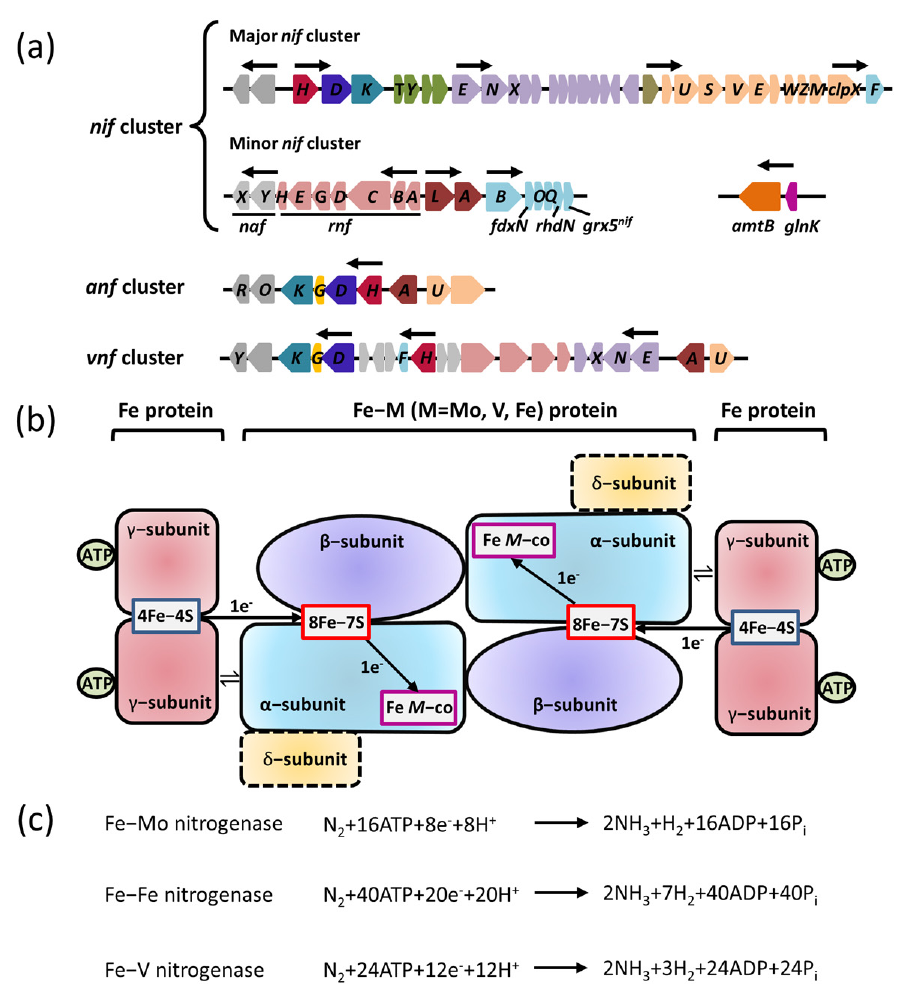
Figure 1. Genes encoding the three forms of nitrogenases and their regulatory proteins are required for nitrogen fixation. ( a ) The organizations of nif , anf , and vnf clusters encoding the three forms of nitrogenases in A. vinelandii . Predicted σ 54–dependent promoter regions are depicted by arrows. Shown are genes encoding the regulatory proteins with known or predicted functions (dark brown), the components involved in the catalytic reduction of N 2 ( nif D in blue; nif K in aqua; nif H in wine red; nif G in yellow), the assembly or stability of nitrogenase (orange), the maturation of nitrogenase (olive), the maturation of Fe–M cofactor (purple), electron transfer (light red), the biosynthesis of Fe–M cofactor (light aqua), and an unknown function (gray). ( b ) A diagram of the three forms of nitrogenases involved in electron transfer. M is Mo, Fe, or V. The α –subunit is encoded by nif K; β –subunit is encoded by nif K; γ –subunit is encoded by nif H; δ –subunit is encoded by nif G. ( c ) The nitrogen–fixation reaction catalyzed by the three forms of nitrogenases.